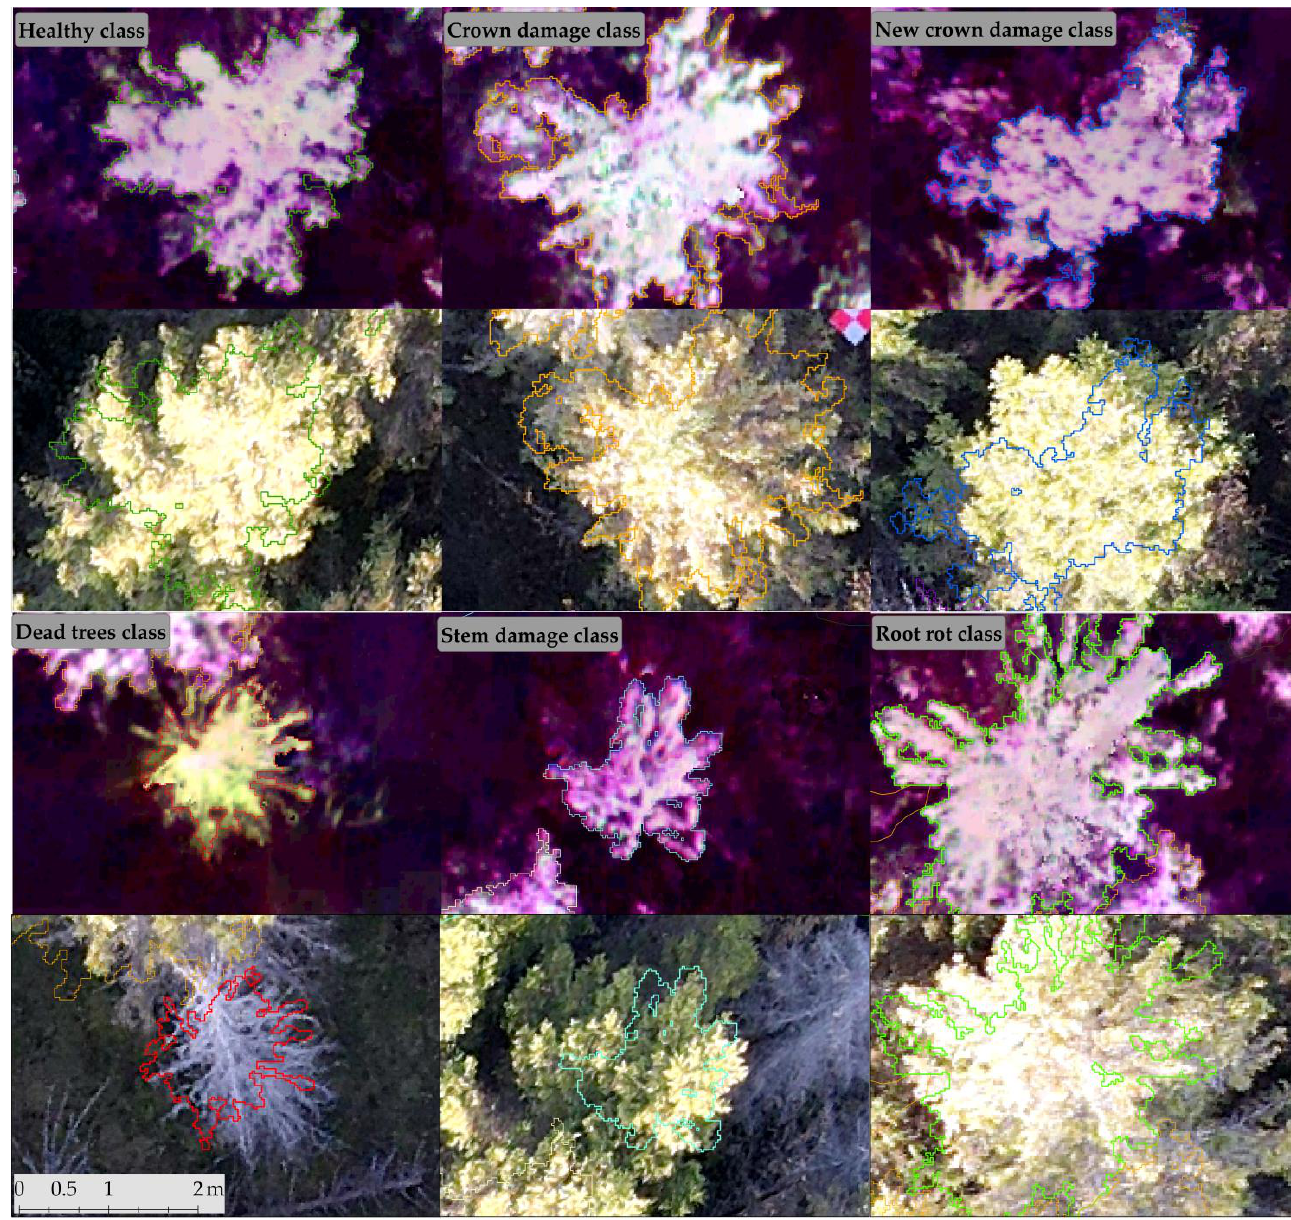
Figure 3. Examples of the SlantRange 3PX orthomosaics (top row) for classified tree health classes and RGB images captured by DJI Mavic air 2 (bottom row) used to update the tree health status .